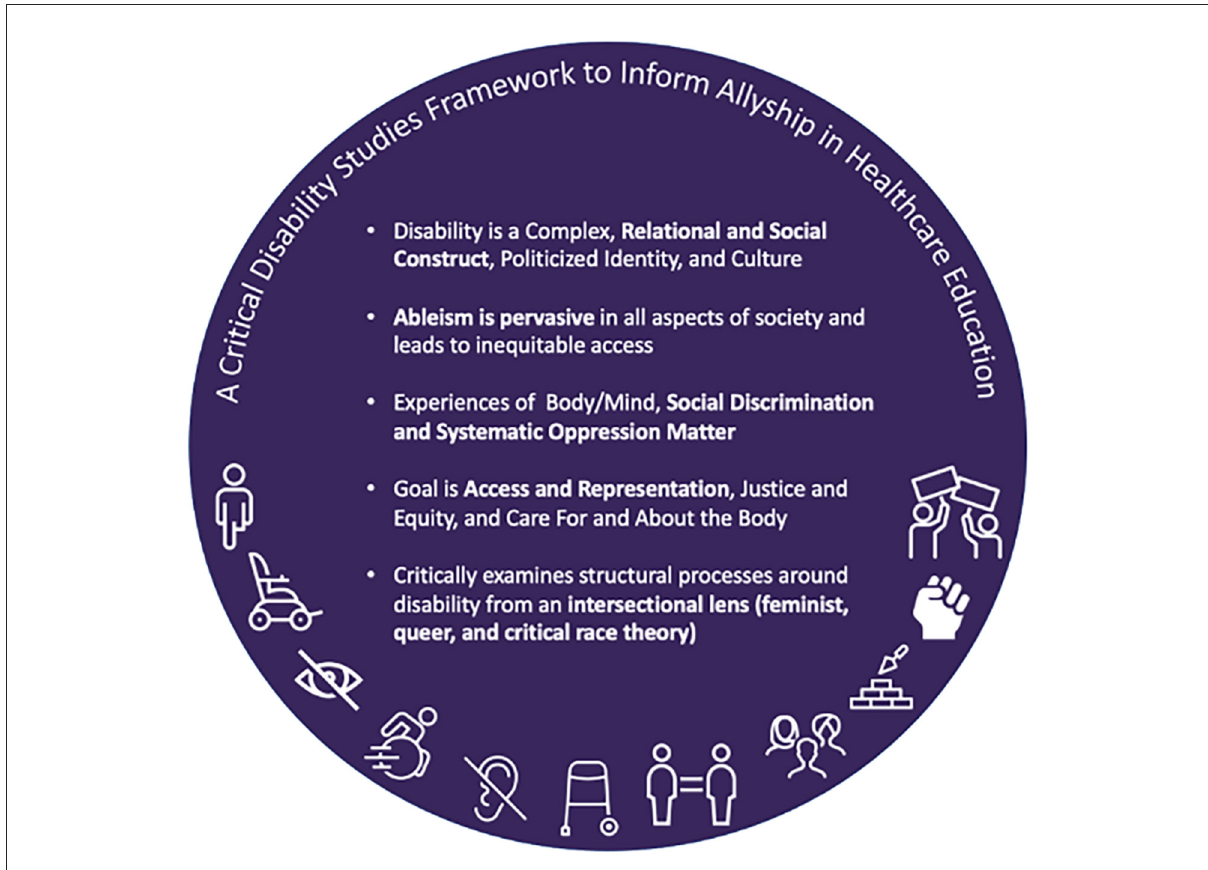
FIGURE1 A list of five core tenets comprising a critical disability studies framework to inform allyship in healthcare education.